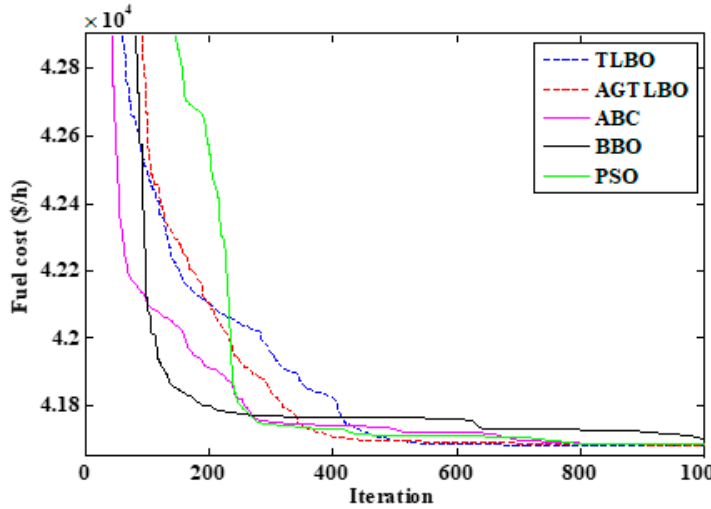
Figure 11. Convergence of algorithms for Case 5.